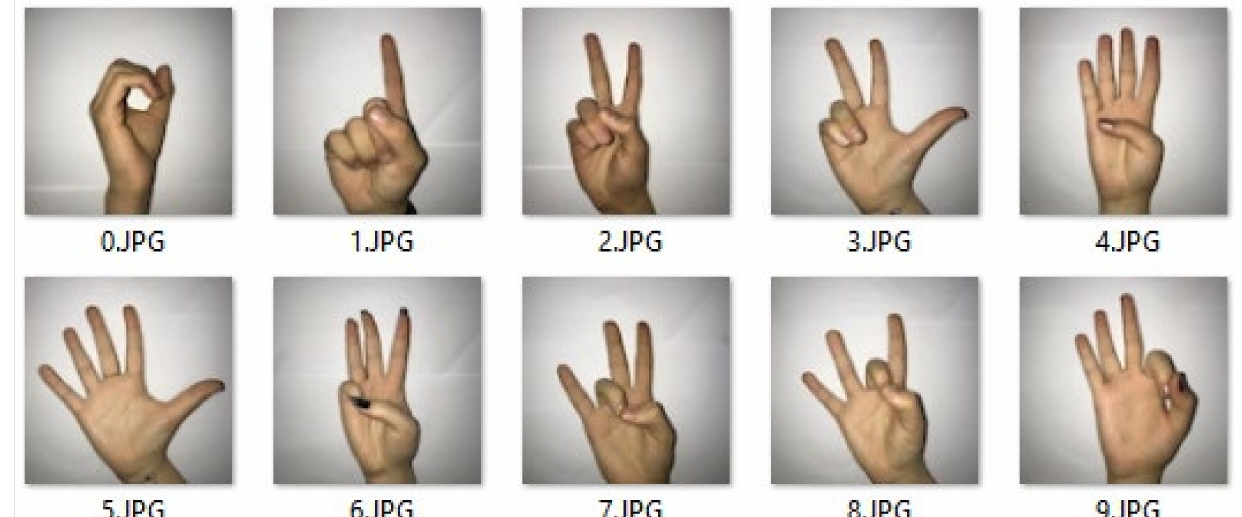
Figure 2. The sample images from Dataset 1.